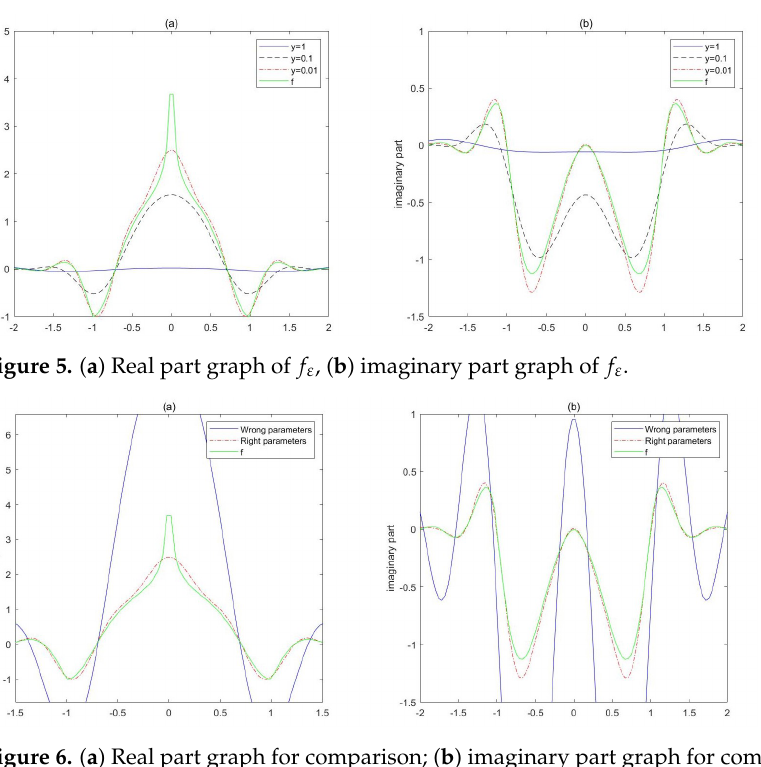
Figure 4. ( a ) Real part graph of f ε ( x ) , ( b ) imaginary part graph of f ε ( x ) , ( c ) section view of real part, and ( d ) section view of imaginary part.